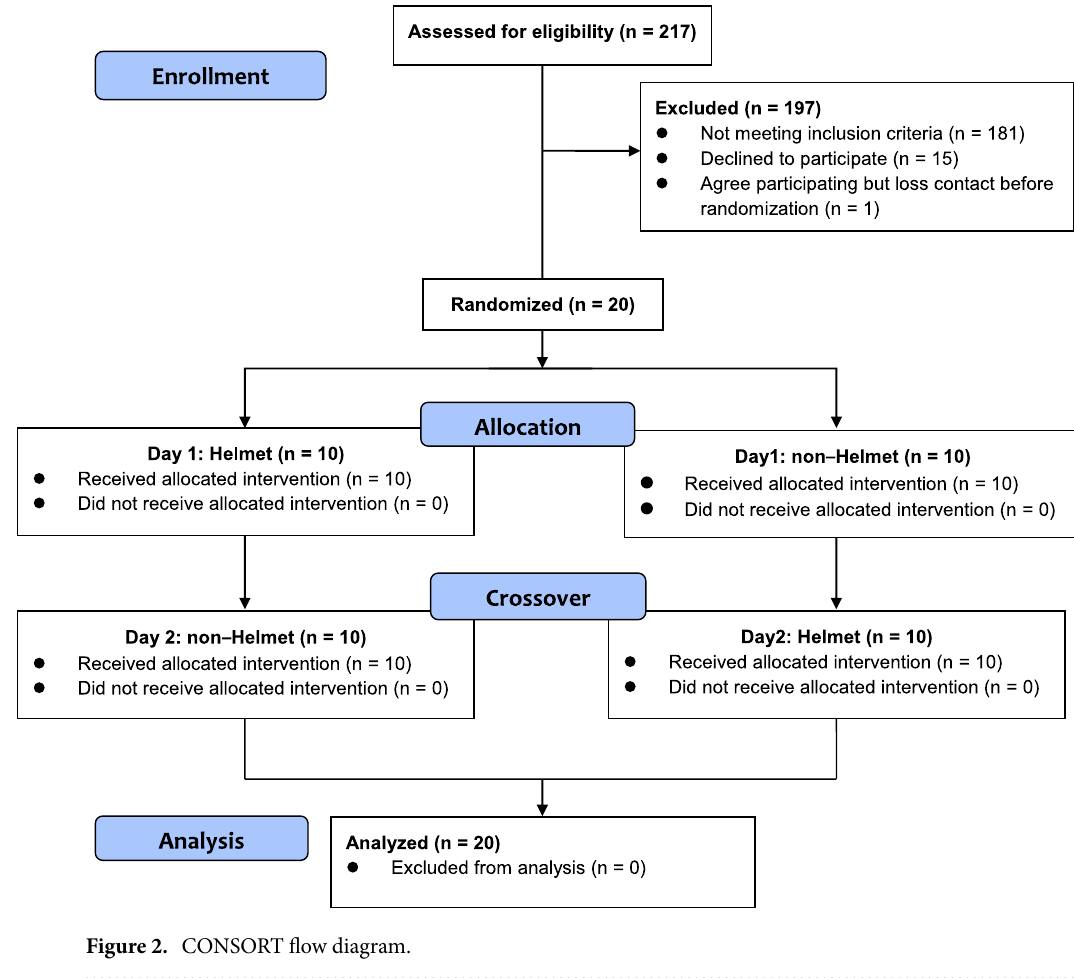
Figure 2. CONSORT flow